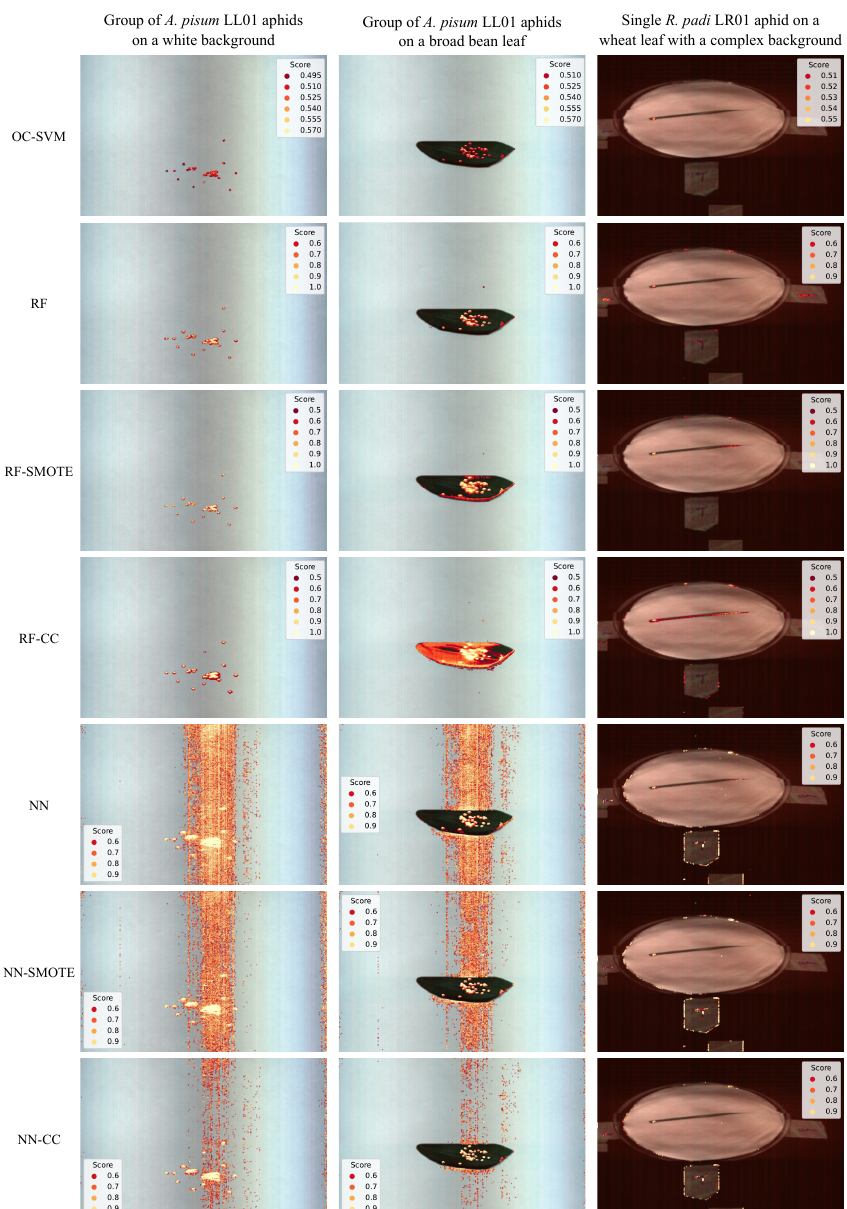
Figure 7. Aphid score for all pixels classified as arising from aphids, assigned by each scheme (represented in each row), on three challenging images. The two first images represent a group of A. pisum LL01 aphids at stage N1 on a white background ( column 1 ) or on a broad bean leaf ( column 2 ), and the third image represents a single R. padi LR01 aphid on a wheat leaf with a complex background ( column 3 ).